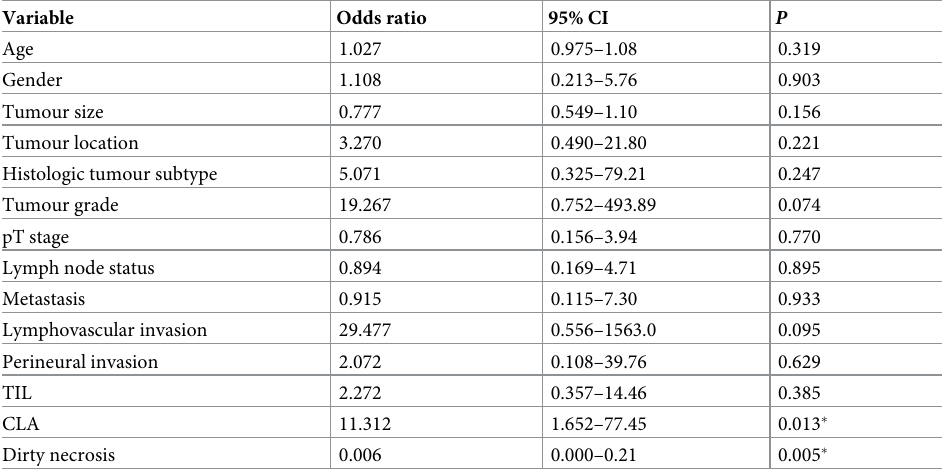
Table 4. Predictors of COX-2 expression among the clinicopathological parameters.